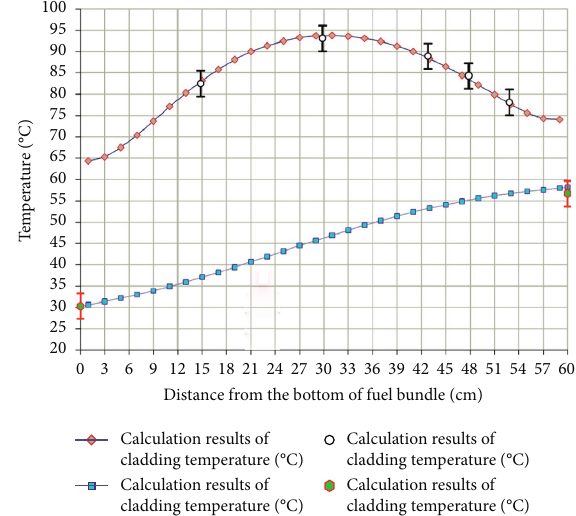
Figure 5: Comparison of the measured cladding temperatures (T 1 ÷ T 5 ) and coolant temperatures (T in , T out ) of the HEU core to calculated those of the LEU core using the PLTEMP/ANL